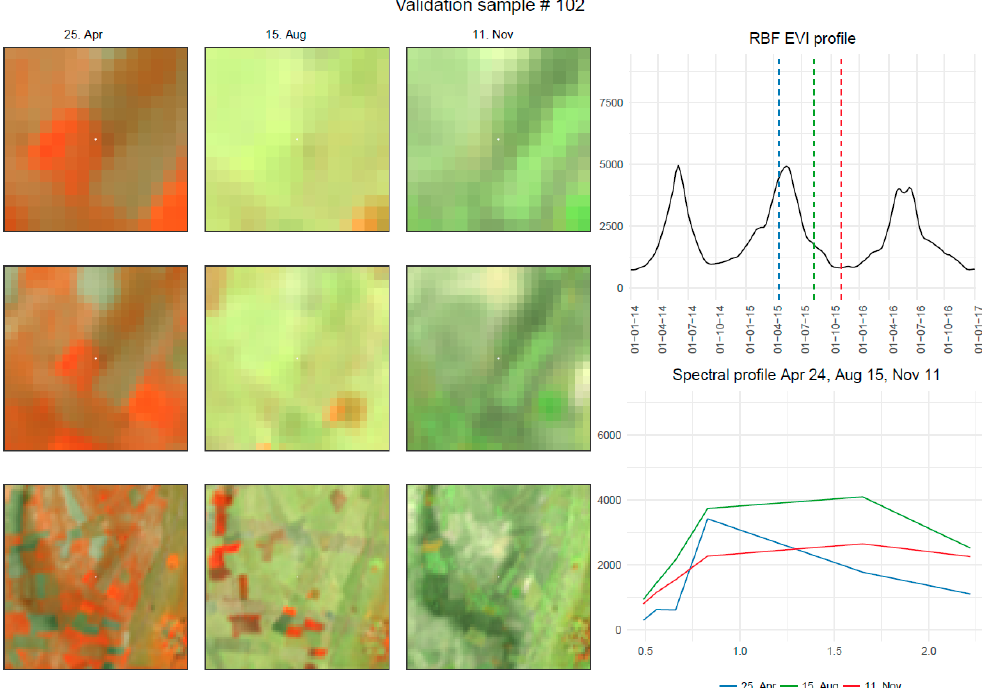
Figure A1. Validation pixel protocol for class spring/winter crop.